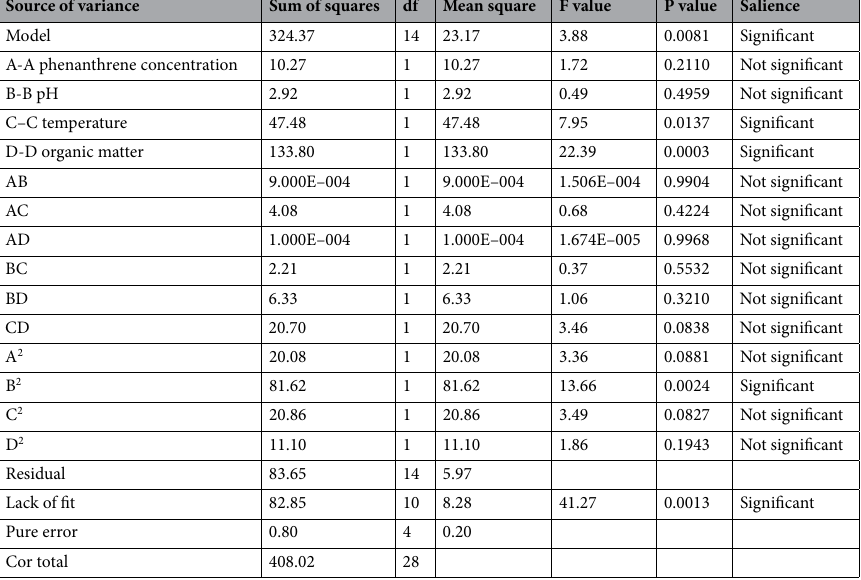
Table 9. Analysis of variance results of silty sand optimization